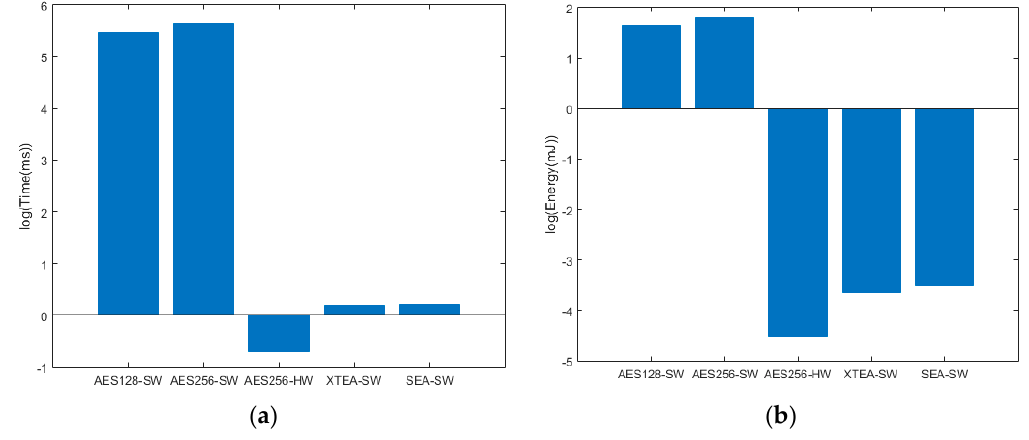
Figure 11. Comparative metrics for a 32-bit MCU: ( a ) Execution time; ( b ) Energy consumption.